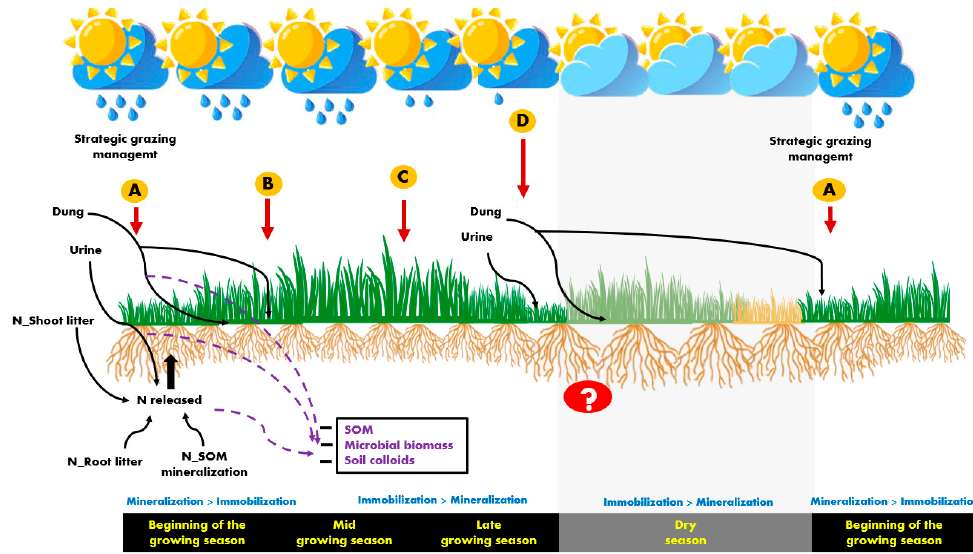
Figure 2. Schematic diagram showing the fate of N into the mineralization and immobilization processes and the possible strategic periods for N fertilizer applications (A, B, C and D). The size of the red arrows indicates the amount of N per instalment. The question mark indicates unpredictable responses during the dry season.